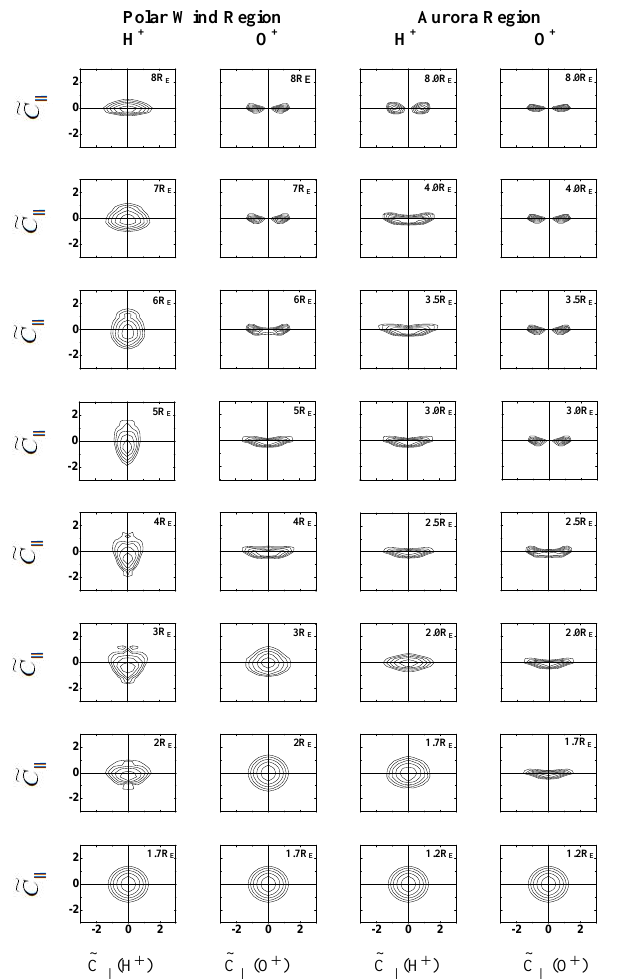
Figure 1. Ion velocity distribution functions at different geocentric altitudes in the polar wind (two left panels) and auroral (two right panels) regions, for H + and O + ions. The ion velocity distribution is represented by equal values contours in the normalized velocity ( ˜ c k , ˜ c ⊥ ) plane, where ˜ c = [ v − u ] / (cid:2) 2 kT/m (cid:3) 1 / 2 , where T is the ion temperature at the given geocentric altitude. The contour levels de- crease successively by a factor e 1 / 2 from the